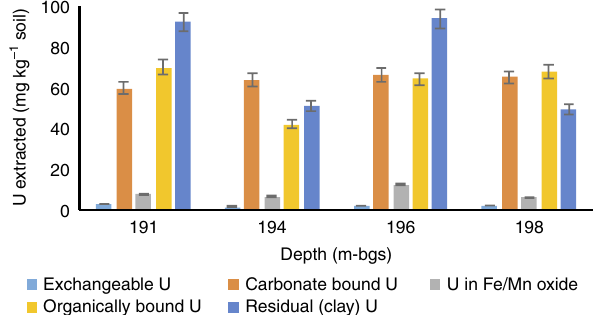
Figure 1 | Sediment associated U fractions from sequential extractions. Bars indicate concentration of uranium (in mgkg (cid:2) 1 ) within each fraction. Error bars indicate 1 s.d. from the mean of triplicate extractions. Total